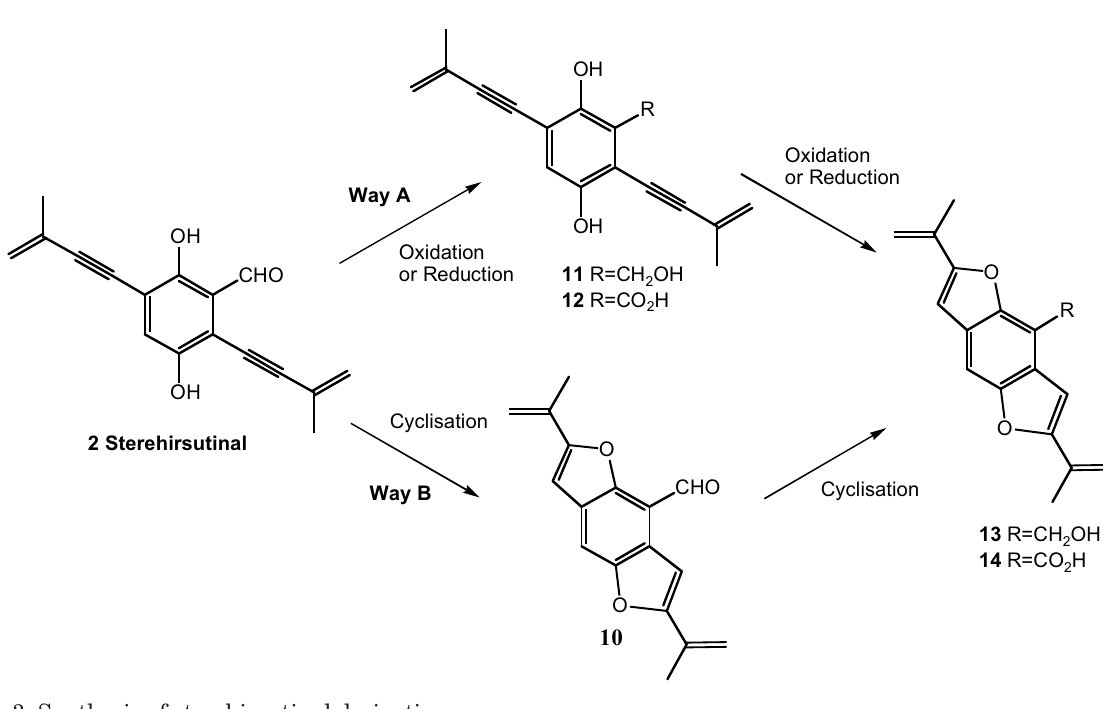
Fig. 3. Synthesis of sterehirsutinal derivatives.